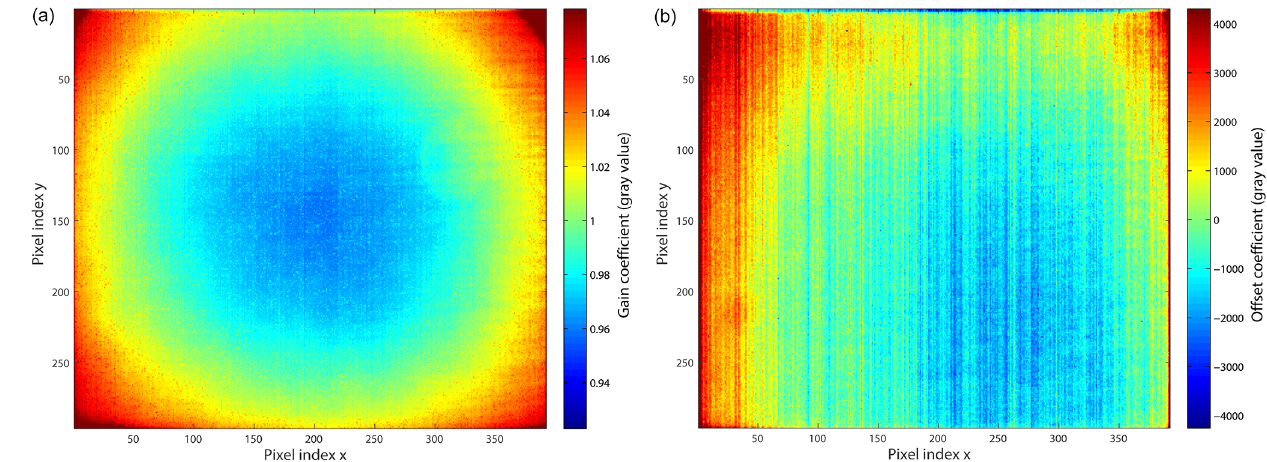
Figure 6. NUC coefficient matrices a ij (a) and b ij (b) . The central symmetric shape of a ij is due to the relation to the pixel-dependent projected solid angle ω fov ,ij .